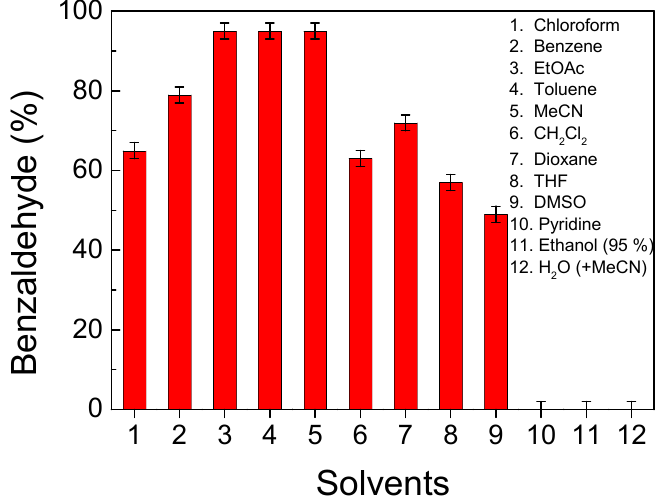
Figure 8. Solvent-dependent benzaldehyde product distribution using (5–1)VAl-MS-L-cal as catalyst (Table S7).